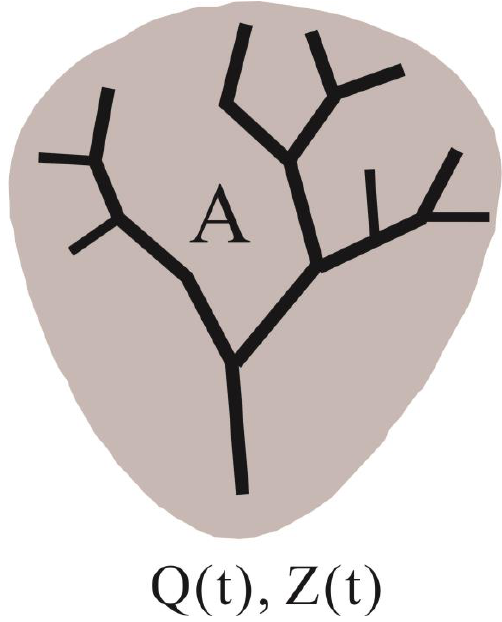
Figure 2. Schematic diagram of the concept of hydrochemical runoff method. Reprinted with permission from Ref. [85], Copyright 2009 Elsevier.